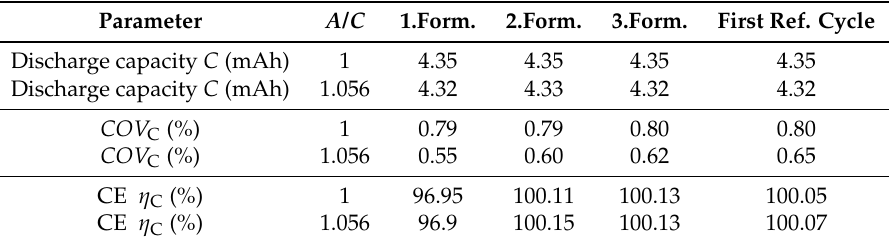
Table 8. Influence of an anode overhang on the formation of the coin cells assembled. Analysis of the three formation cycles and the first reference cycle during aging procedure. All four cycles are carried out for the same C/3 current